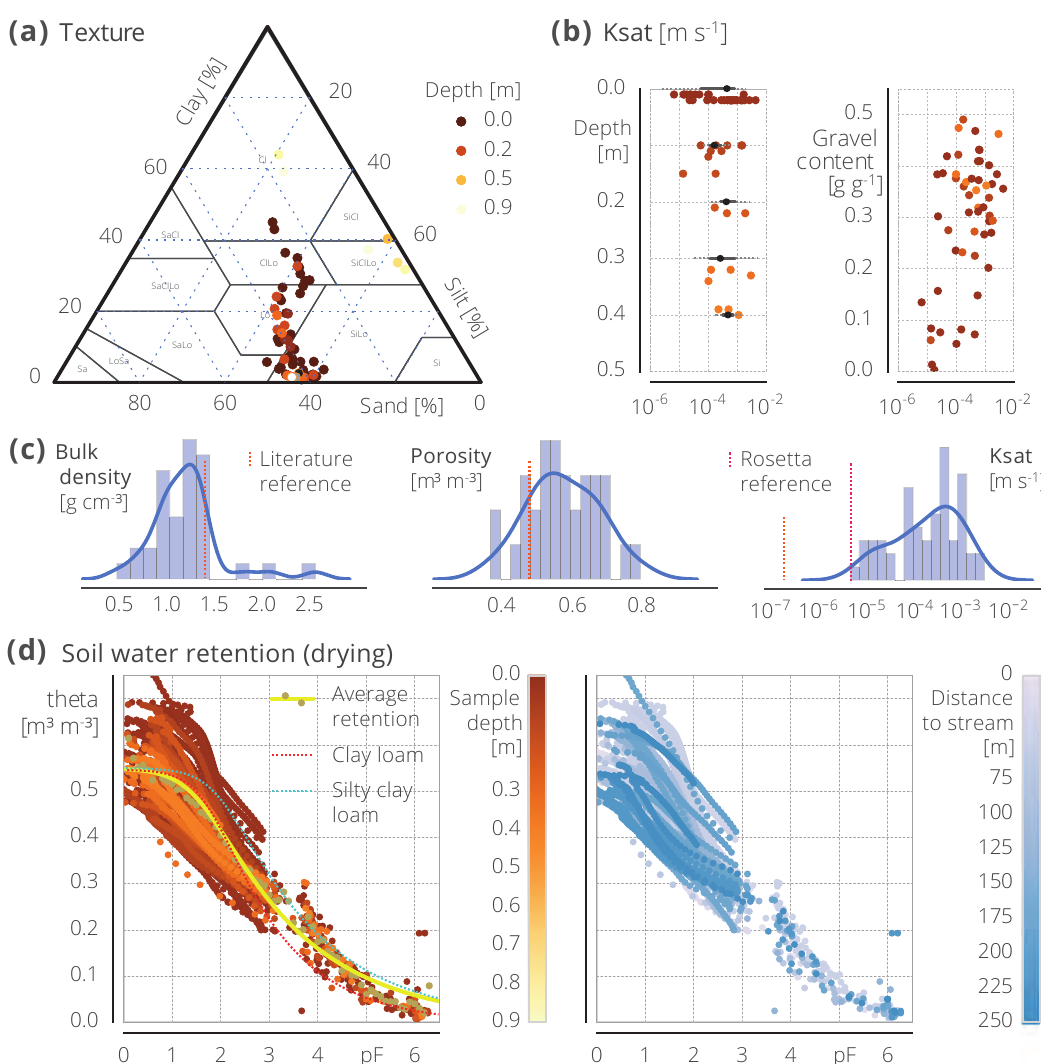
Figure 4. Results of laboratory analyses of 63 undisturbed 250mL ring samples. (a) Soil texture analyzed with wet sieving and sedimentation (pipette method). Saturated hydraulic conductivity (Ksat) measured with the Ksat apparatus and plotted against sample depth and gravel content. Black box plots of the respective depth increment. (b) Histograms and kernel density estimate of measured bulk density, porosity and Ksat. Reference as the mean silty loam value from the literature (Hillel, 1980; Rawls et al., 1982; Carsel and Parrish, 1988). Rosetta (Schaap et al., 2001) reference based on mean values of samples (15.7, 47.9, 36.4% sand, silt, clay and BD 1.1gcm − 3 ). (c) Soil water retention relation measured with the Hyprop and the WP4C apparatus with the average retention estimate (respective mean of each 0.05pF- bin and fitted van Genuchten model) and literature references (Carsel and Parrish, 1988) scaled to measured average θ s and θ r